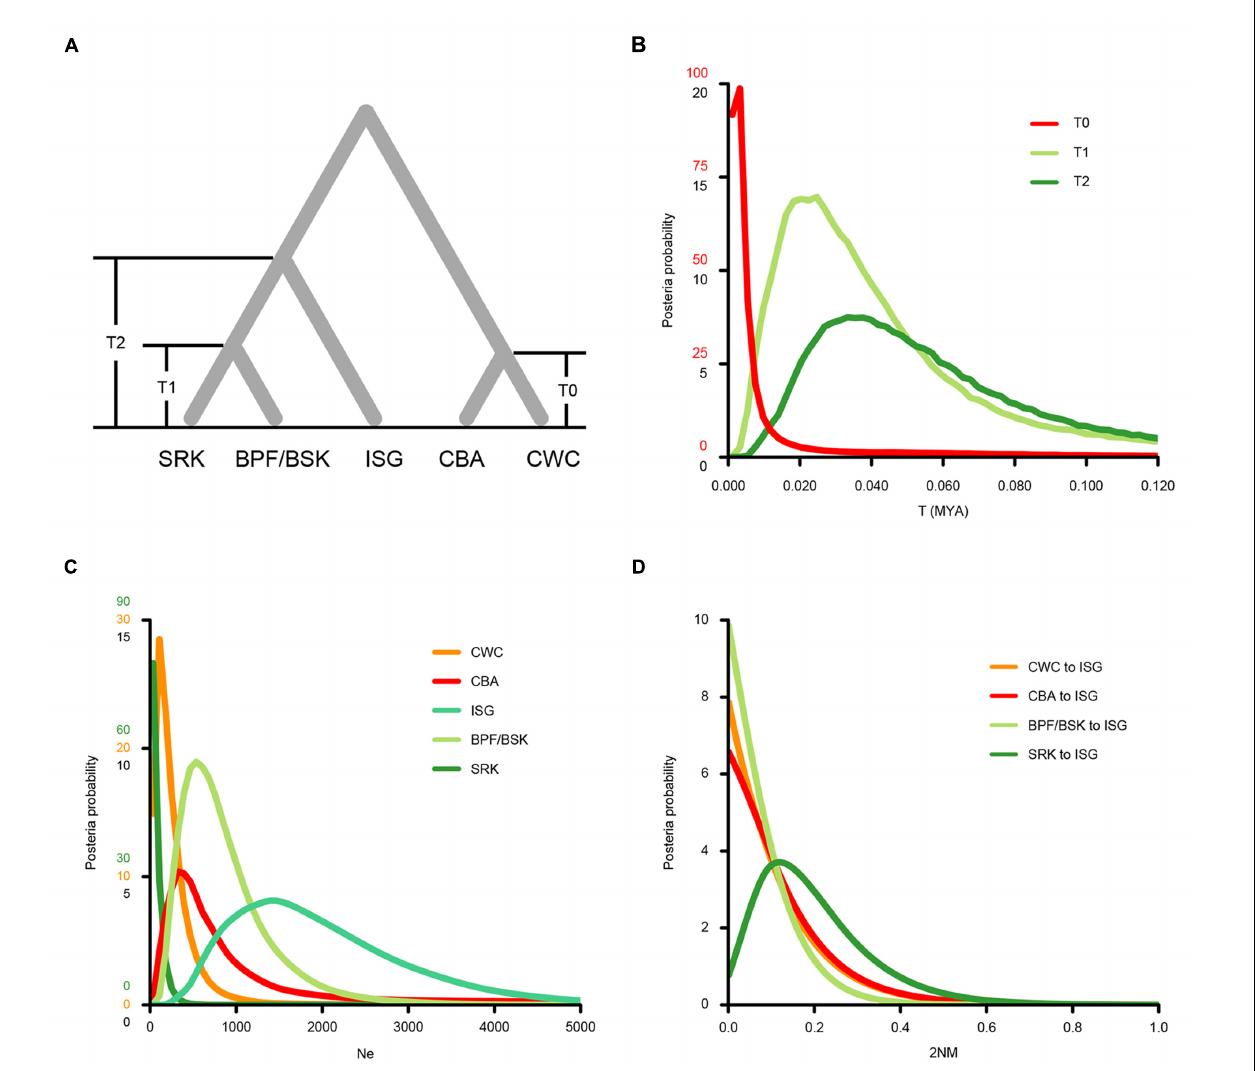
FIGURE 5 | Probability density plots of the demographic parameters estimated from the isolation with migration model for populations from the SCS (CWC and CBA), the Indian Ocean (SRK, BSK and BPF) and the Indo-Pacific boundary region (ISG). (A) A schematic of the isolation with migration model. Population abbreviations are defined in Table 1 . (B) Probability density of the divergence time between CWC and CBA (T0), between the Sri Lanka population (SRK) and two Bangladesh populations (BSK and BPF, T1) and the formation time of the ISG population (T2). (C) Probability density of the effectively population sizes (Ne) of the five populations. (D) Probability density estimation of the migration rate from the CWC, CBA, BSK and BPF and SRK to ISG